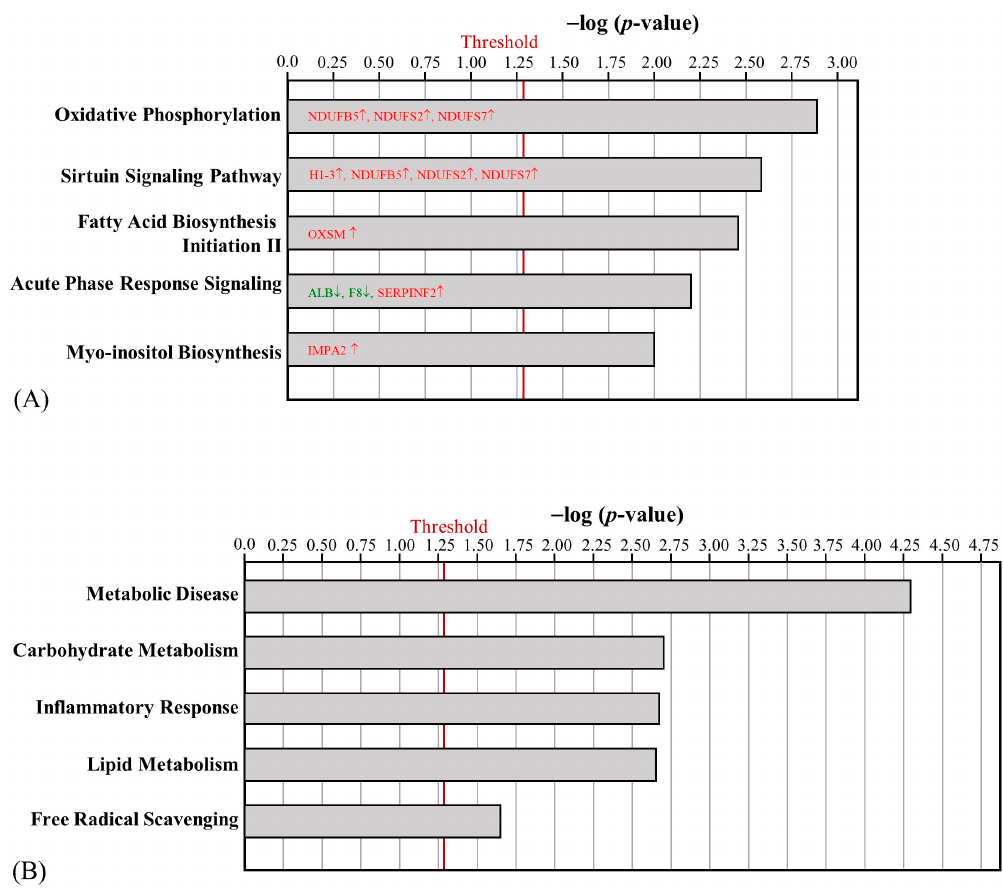
Figure 4. Effect of AE on the canonical pathways ( A ) and biofunctions ( B ) regulated by skeletal muscle proteins between the HFD and AE groups. (The proteins with red letters were upregulated, whereas those with green letters were downregulated).